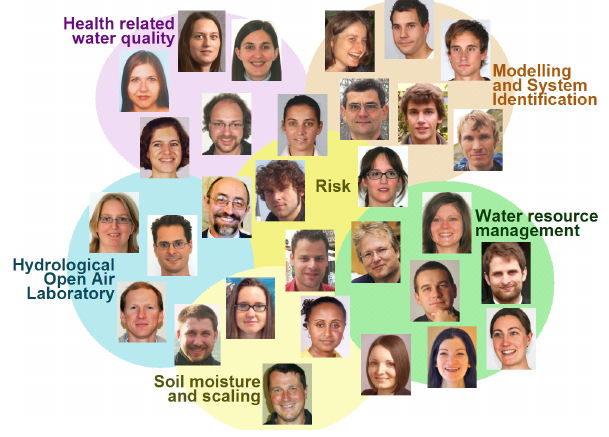
Fig. 3. Research cluster groups of the Vienna Doctoral Programme on Water Resource